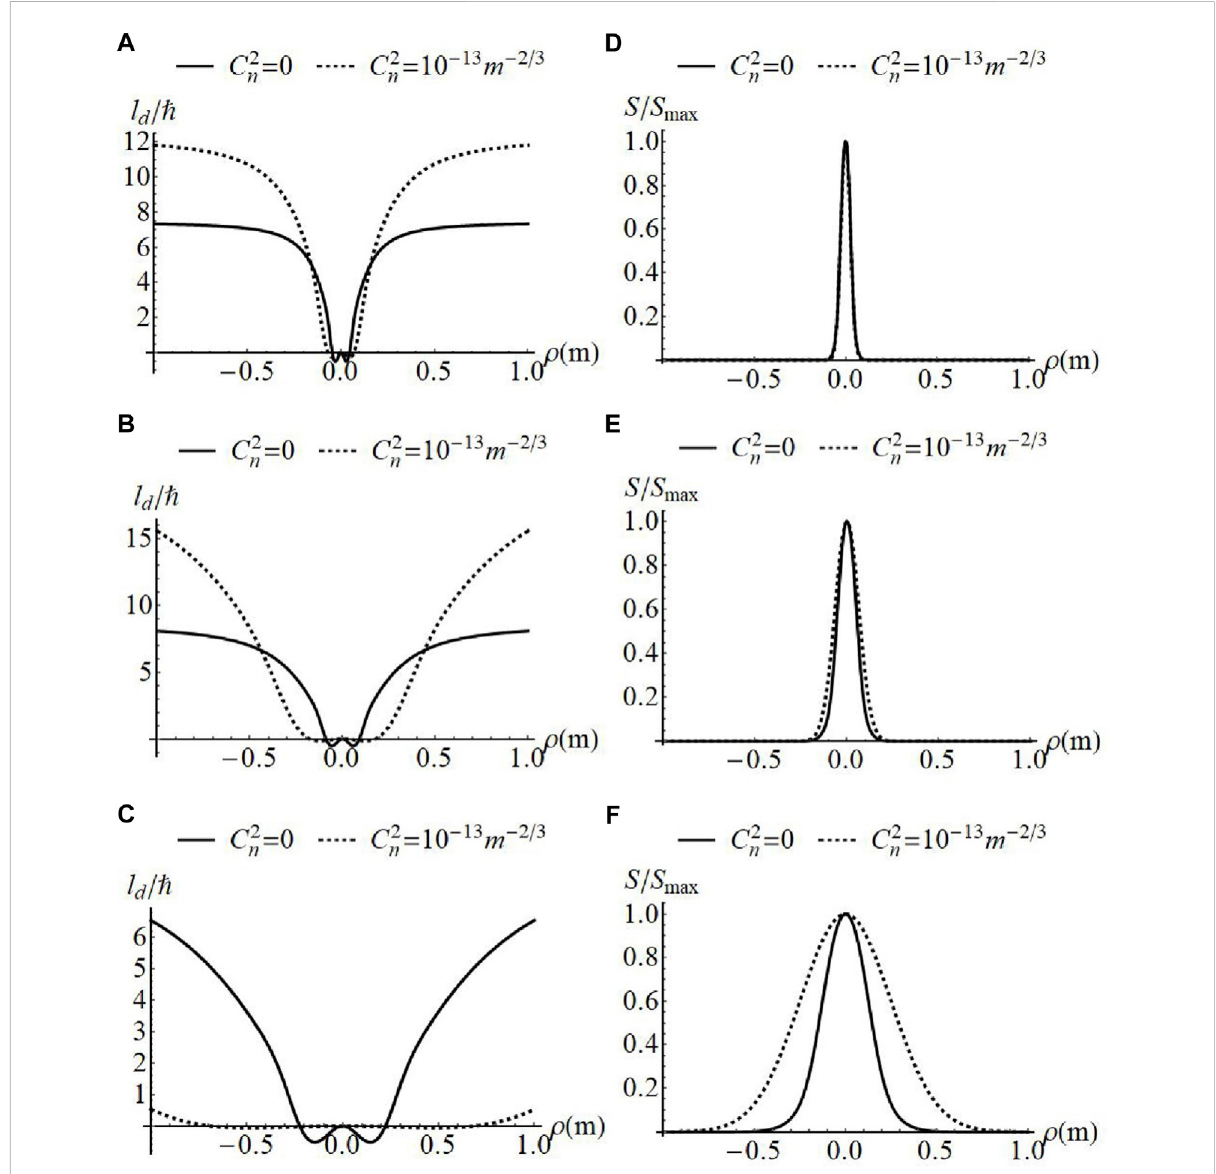
FIGURE 4 Normalized OAM fl ux density (A – C) and spectral density (D – F) of superposed GSMV beams with w = 10 mm, δ + (cid:2) 5mm, δ − (cid:2) 10mm, at z = 1 km (A,D) , z = 2 km (B,E) , and z = 5 km (C,F)